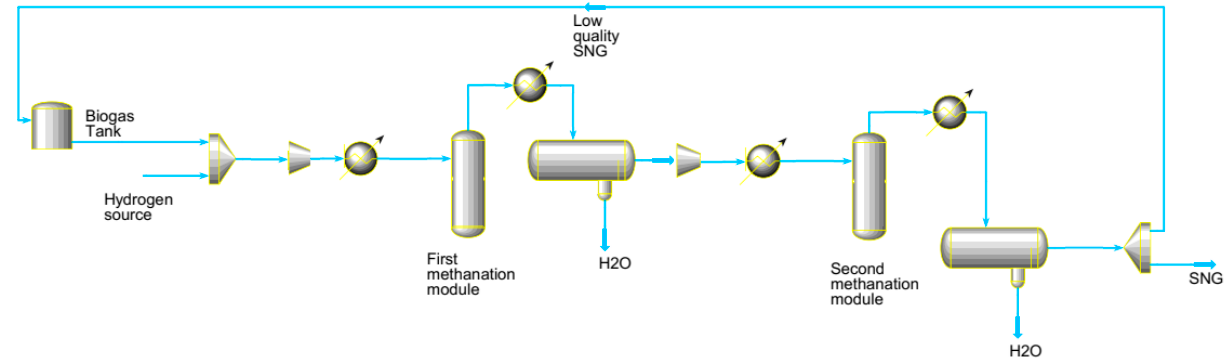
Figure 1. Modular biogas upgrade system (Schematical).